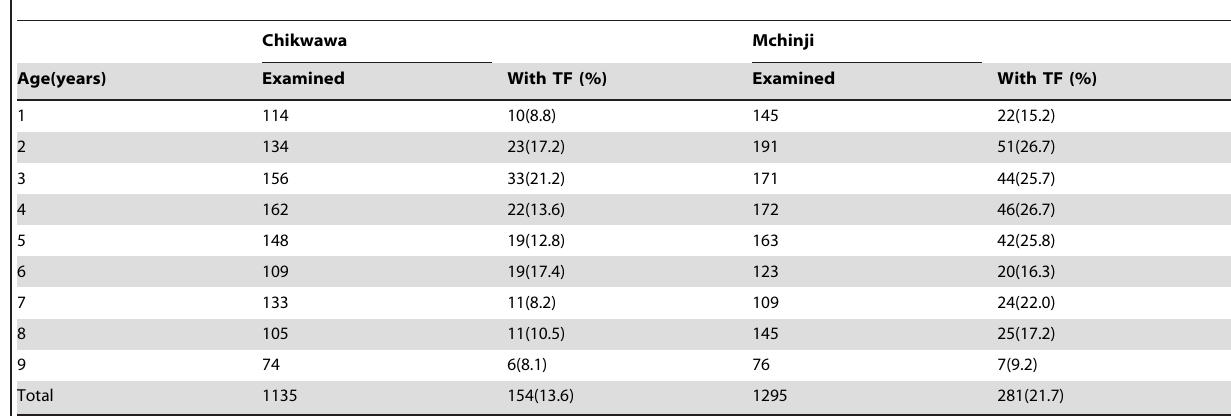
Table 4. Prevalence of Trachoma follicles (TF) by age in Chikwawa and Mchinji districts.